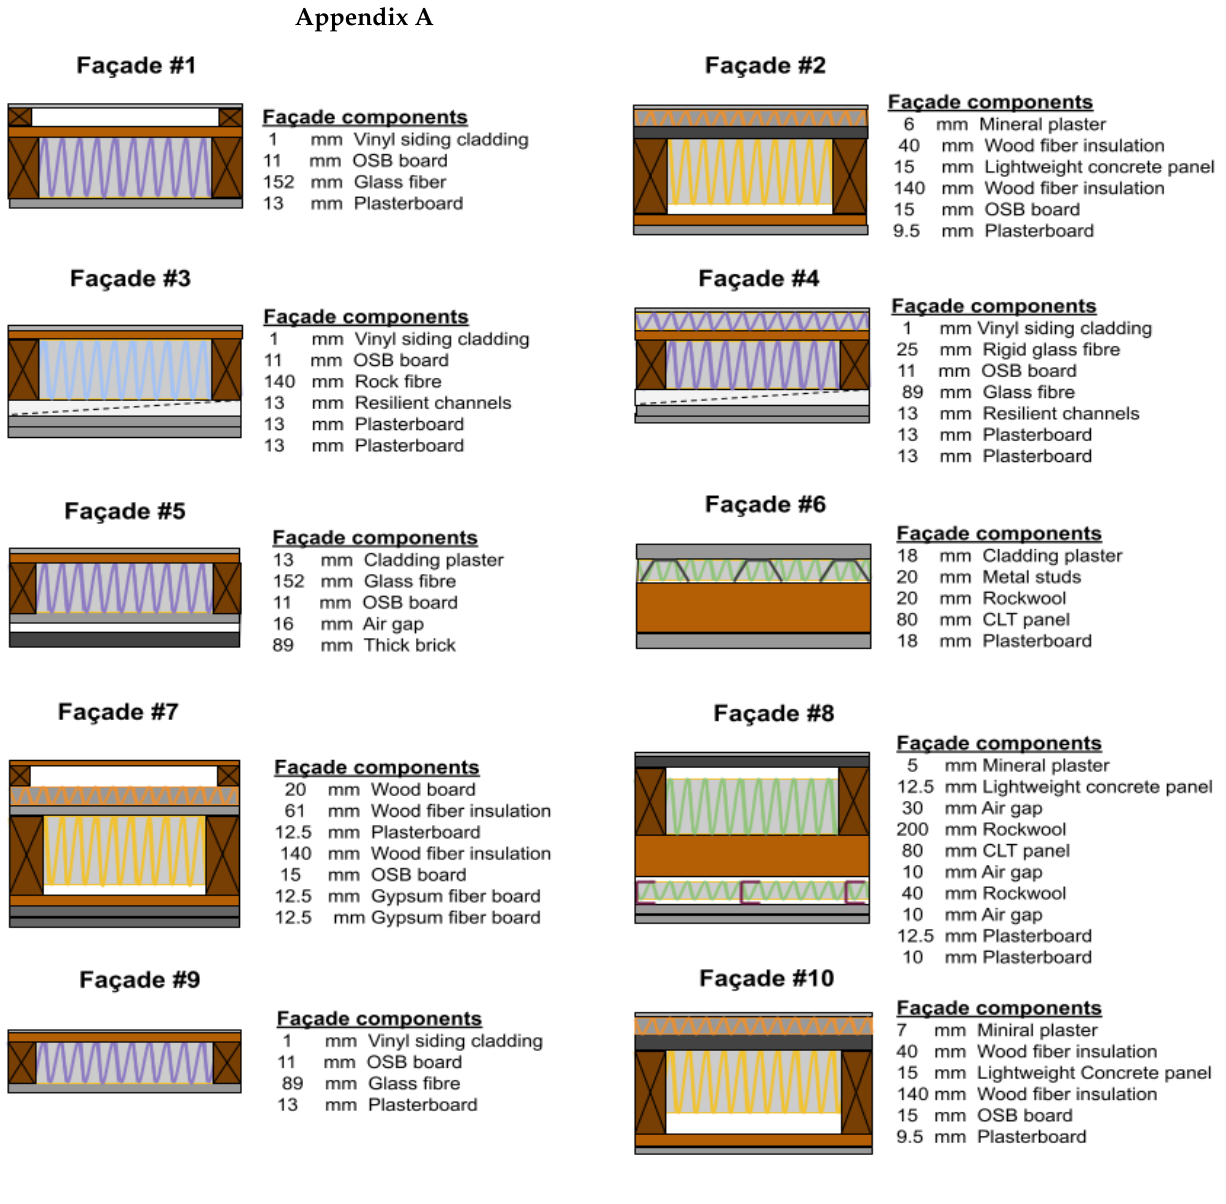
Figure A1. Structural components of the tested façad walls that have been selected to test the accuracy of the network model in prediction of airborne insulation